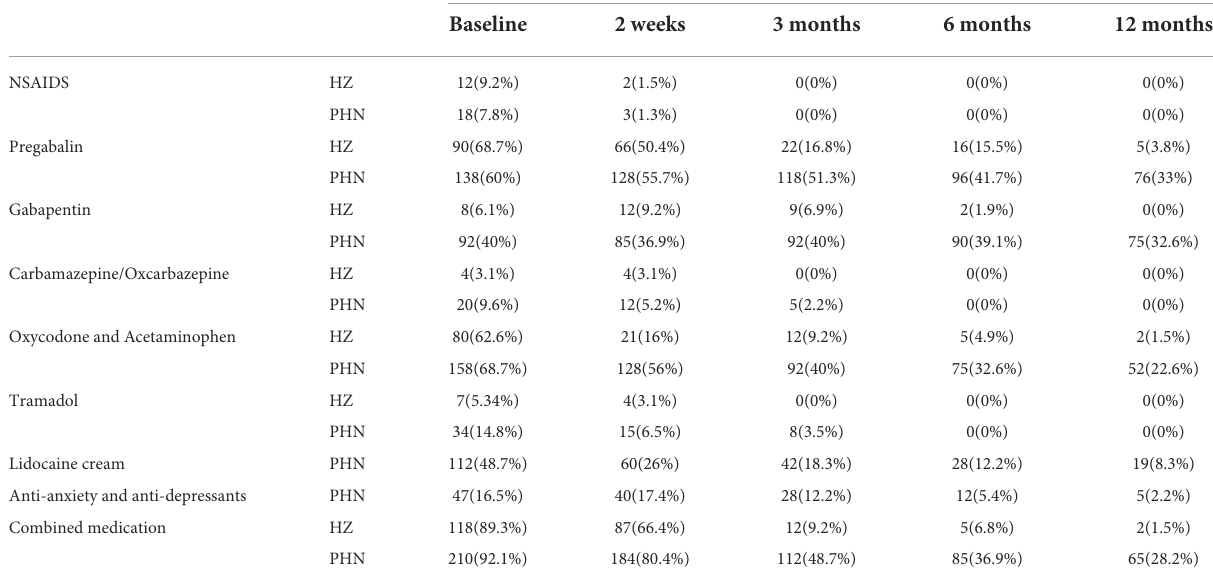
TABLE 6 Medication for patients with HZ and